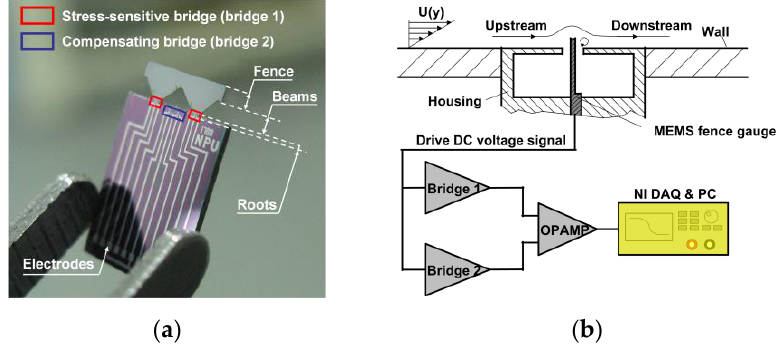
Figure 2. ( a ) The MEMS surface fence and its structure. ( b ) The working principle diagram of the shear-stress sensor and its simplified measurement setup.